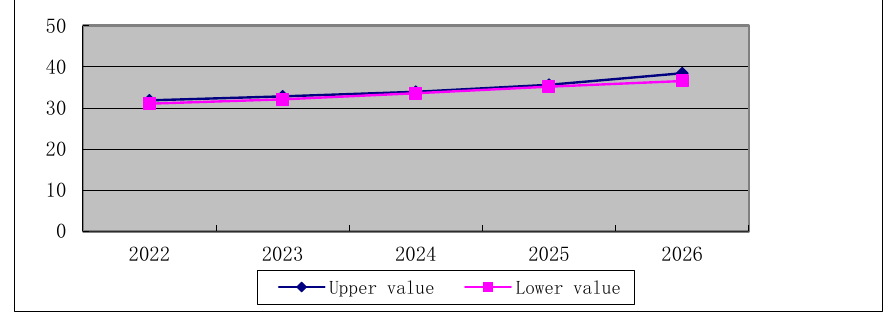
Figure 7. The variation interval of water requirement with the influence of the secondary industry in Tianjin.